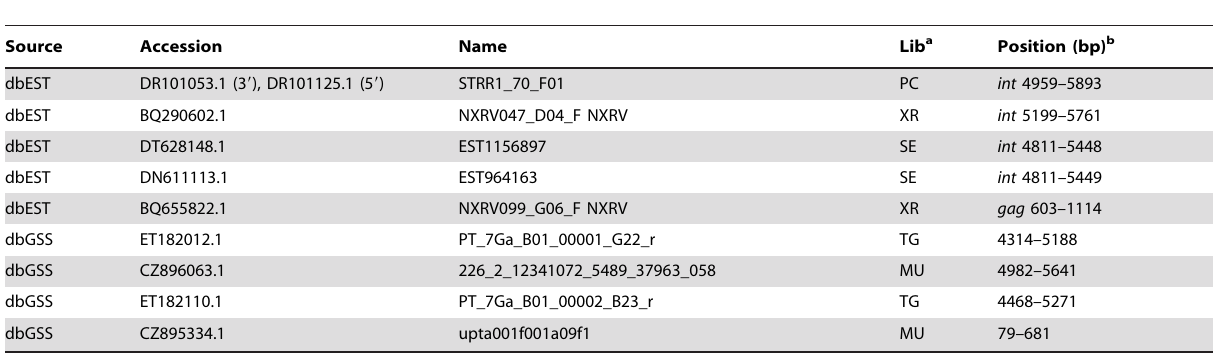
Table 1. Gymny in Pinus taeda sequence databases (GenBank).